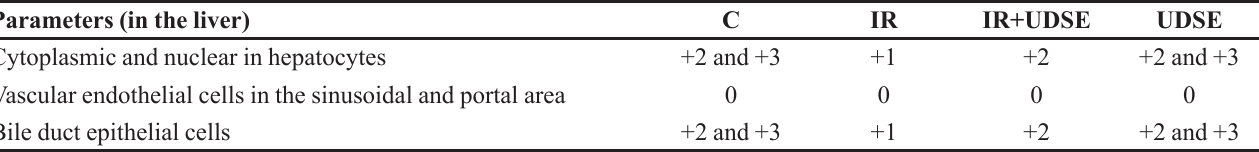
TABLE I - Distribution of GPx1 immunoreactivity according to the groups in the protective efficacy of UDSE on liver tissues of experimentally-irradiated rats Parameters (in the